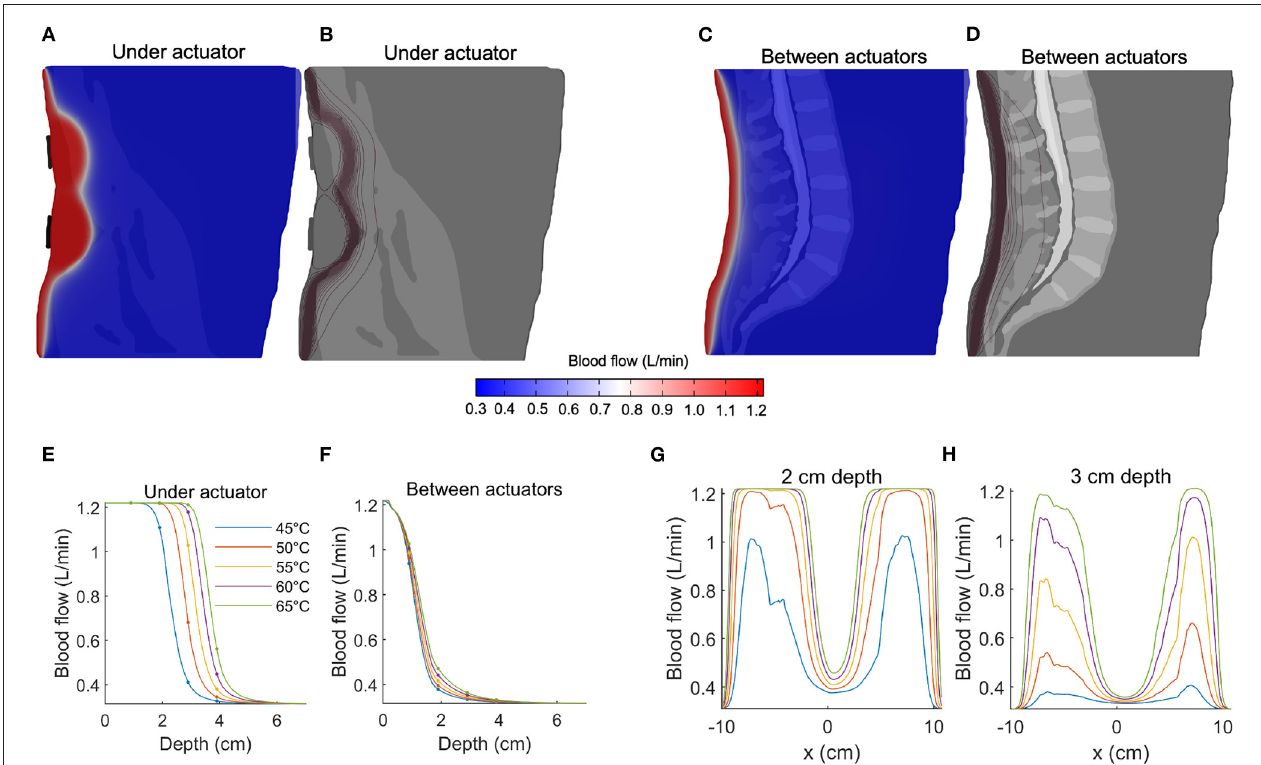
FIGURE 3 | Predicting blood flow increases during thermal massage. (A) The predicted blood flow at a sagittal slice of the back, immediately anterior to the actuator. The actuator temperature was set to 65 ◦ C. Compared to temperature ( Figure 2 ), pronounced increases in blood flow are observed at greater depths. (B) Contours of the blood flow distribution in (A) , where the concentration of the contours indicates a sharp transition region from high to low blood flow. (C) The predicted blood flow at a sagittal slice located between actuators. The increase in blood flow is visibly dampened. (D) Contours of the blood flow distribution in (C) , where the transition region is observed at a relatively shallow depth compared to (B) . (E) The blood flow achieved immediately anterior to the actuators, shown for five different actuator intensities. Due to the sigmoidal nature of the temperature-circulation relationship, the falloff with depth occurs at a larger depth (between 2-4 cm, depending on actuator setting). Four-fold increases in circulation are predicted at depths of 2–3 cm. (F) Same as (E) but now shown for a sagittal slice located between the actuators. The increase in blood flow is no longer apparent beyond a depth of 3–4 cm. (G) The distribution of blood flow as a function of left-to-right position, shown for a fixed 2 cm depth. The predicted blood flow saturates (4x increase relative to baseline) across large sections of the back. (H) Same as (G) but now shown for a depth of 3 cm. When located directly anterior to the actuator, the predicted blood flow reaches a three-fold increase at an actuator temperature of 55 ◦